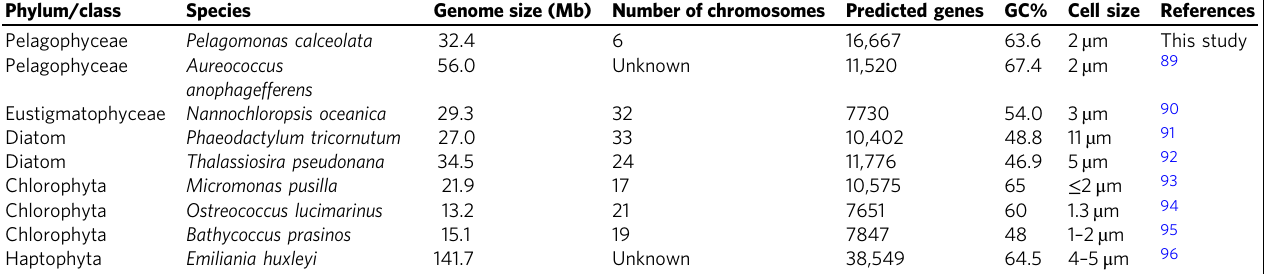
Table 1 Genome characteristics of several unicellular photosynthetic